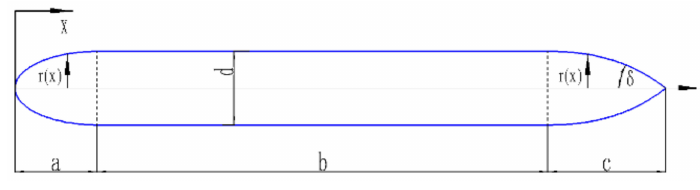
Figure 1. MYRING hull